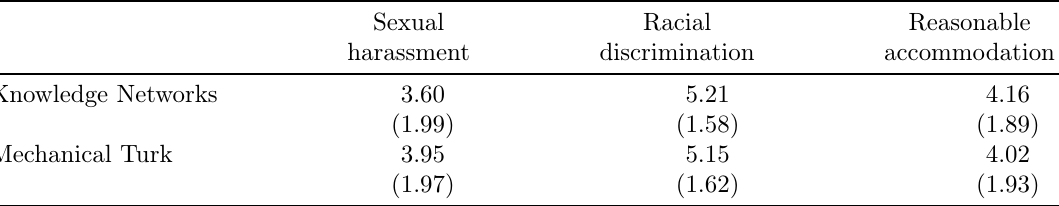
Table 2: Means and standard deviations of key outcome variables of each experiment